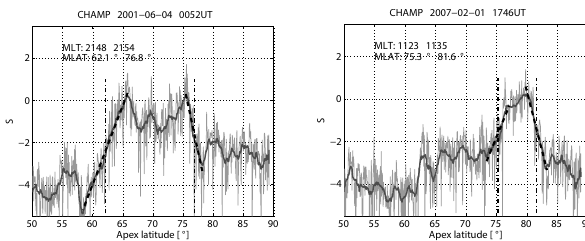
Figure 2. Boundaries (dashed-dot lines) of the auroral oval for the two examples of CHAMP FAC signatures as shown in Fig. 1. For the detection approach see